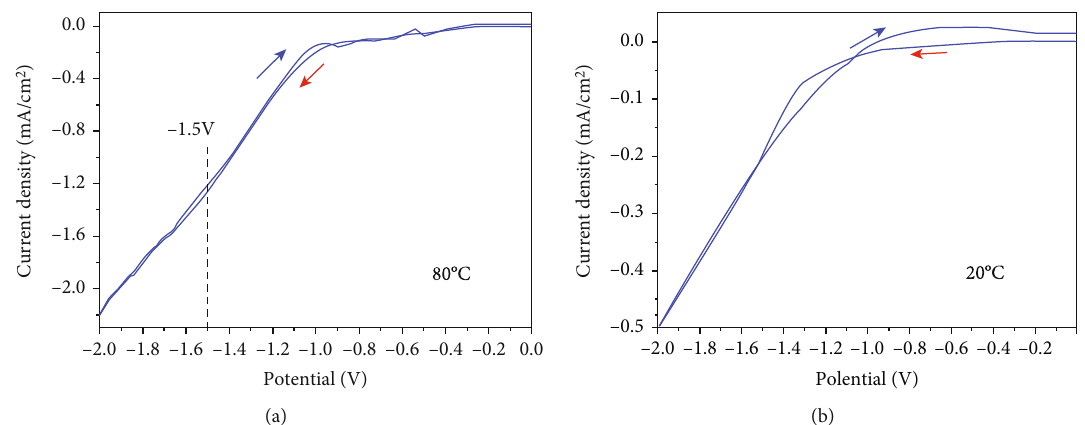
) aqueous solutions on FTO-coated glass with the working and counter electrode 3 2